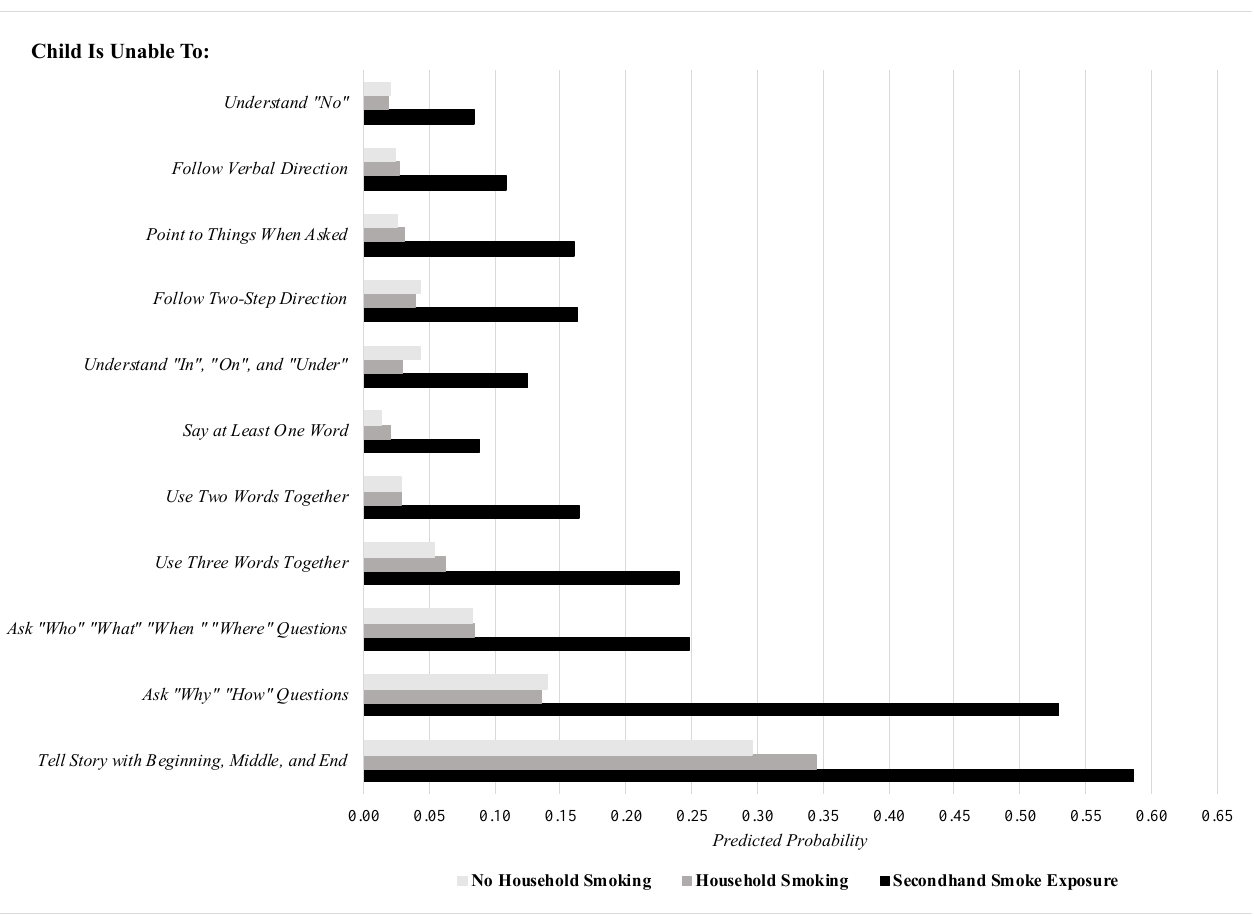
Figure 1. The predicted probability of specific early language difficulties among males, stratified by ETS categories (covariates set to means). Note: predicted probabilities comparing smoking inside housing unit to no household smoking are all statistically significant at the p < 0.05 level